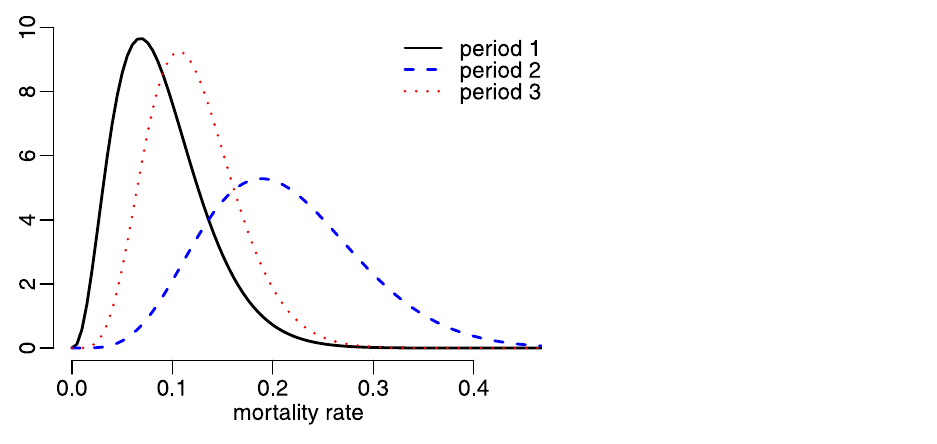
Fig 9. Fitted beta densities, state